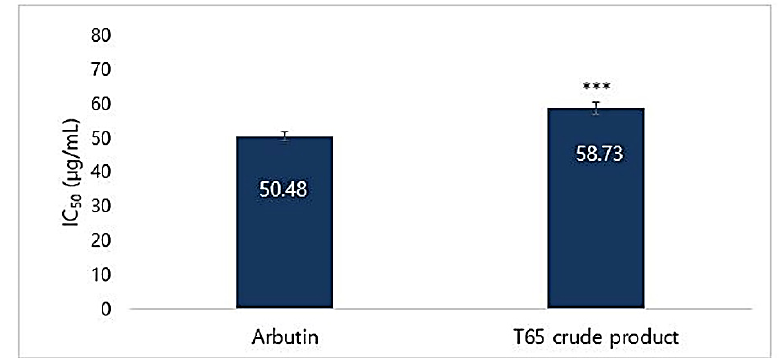
Figure 10. IC 50 of mushroom tyrosinase inhibition by T65 crude product and arbutin. Data are given as mean ± SEM and statistical significance is shown by ANOVA (*** p < 0.001).